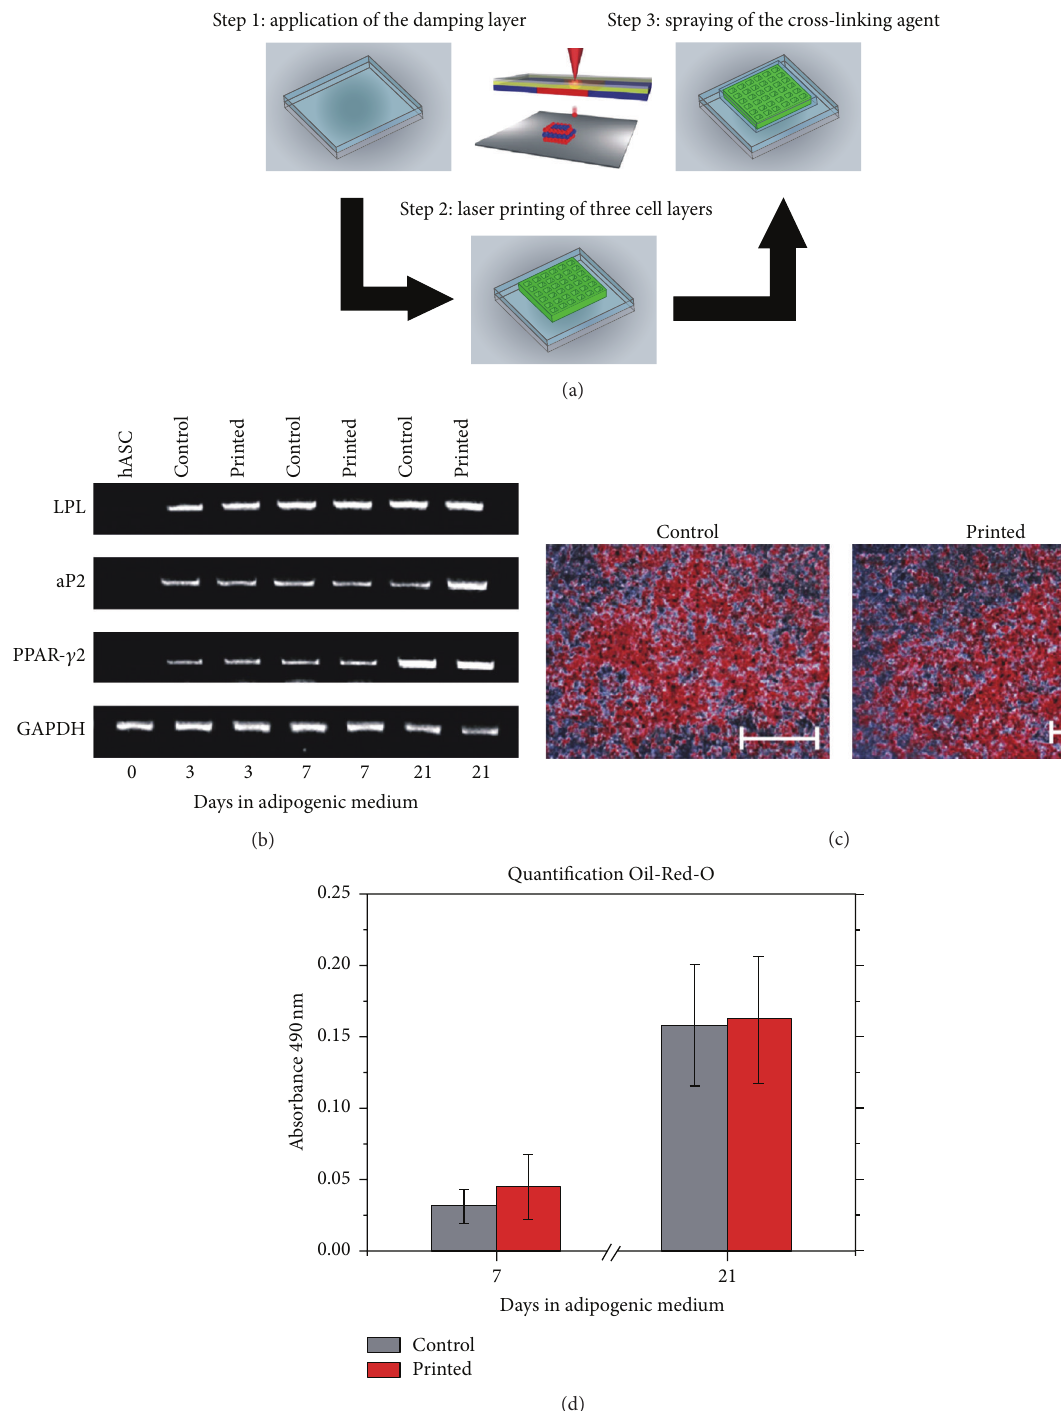
Figure 2: Laser-assisted bioprinting helps in the proliferation and differentiation of ASCs. (a) Three-dimensional scaffolds were fabricated via laser-assisted bioprinting. During printing, the laser pulse was applied to melt a certain area in the energy absorbing layer (red layer). The suspended biomaterial prepolymers below that area fell due to the loss of support from the absorbing layer. The small units formed droplets that were collected by the bottom substrate. The prepolymers were cross-linked using a cross-linking agent. (b) Lipase (LPL), adipocyte fatty acid-binding protein (aP2), and peroxisome proliferator-activated receptor (PPAR- 𝛾 2) expression were compared on printed and nonprinted control ASCs compared to unstimulated ASCs after 3, 7, and 21 days of incubation. (c) Oil Red-O staining indicated similar lipid accumulation in the cytoplasm of the printed and nonprinted groups (scale bar: 500 𝜇 m). (d) Equal lipid quantities were detected in both groups ( 𝛼 = 0.05) (adopted from